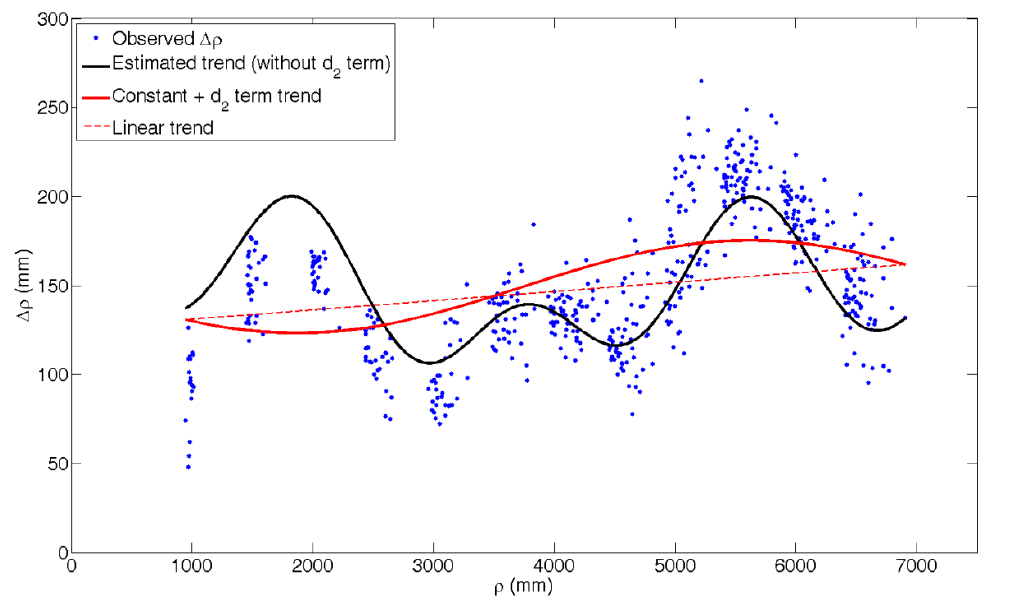
Figure 6. Two-step independent calibration range differences and error model